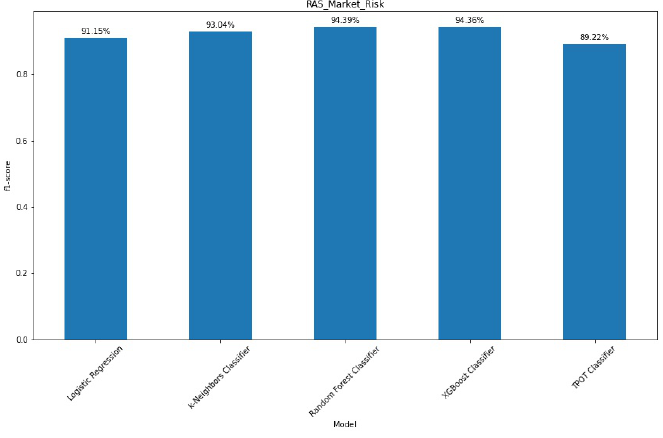
Figure 6. F1-scores of each model, using cross-validation